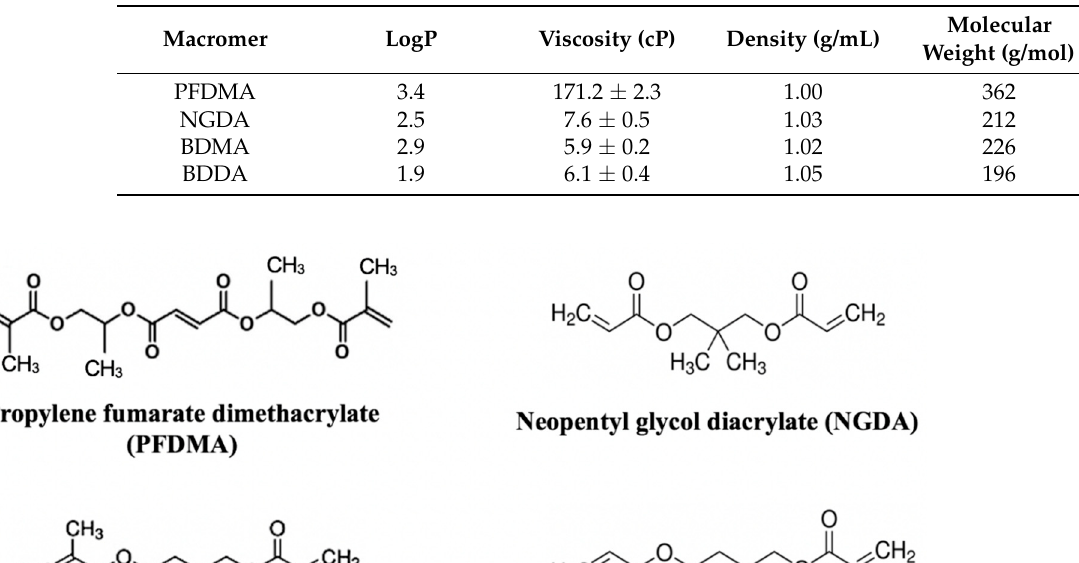
Table 1. Physical and chemical properties of PFDMA, NGDA, BDMA, and BDDA.